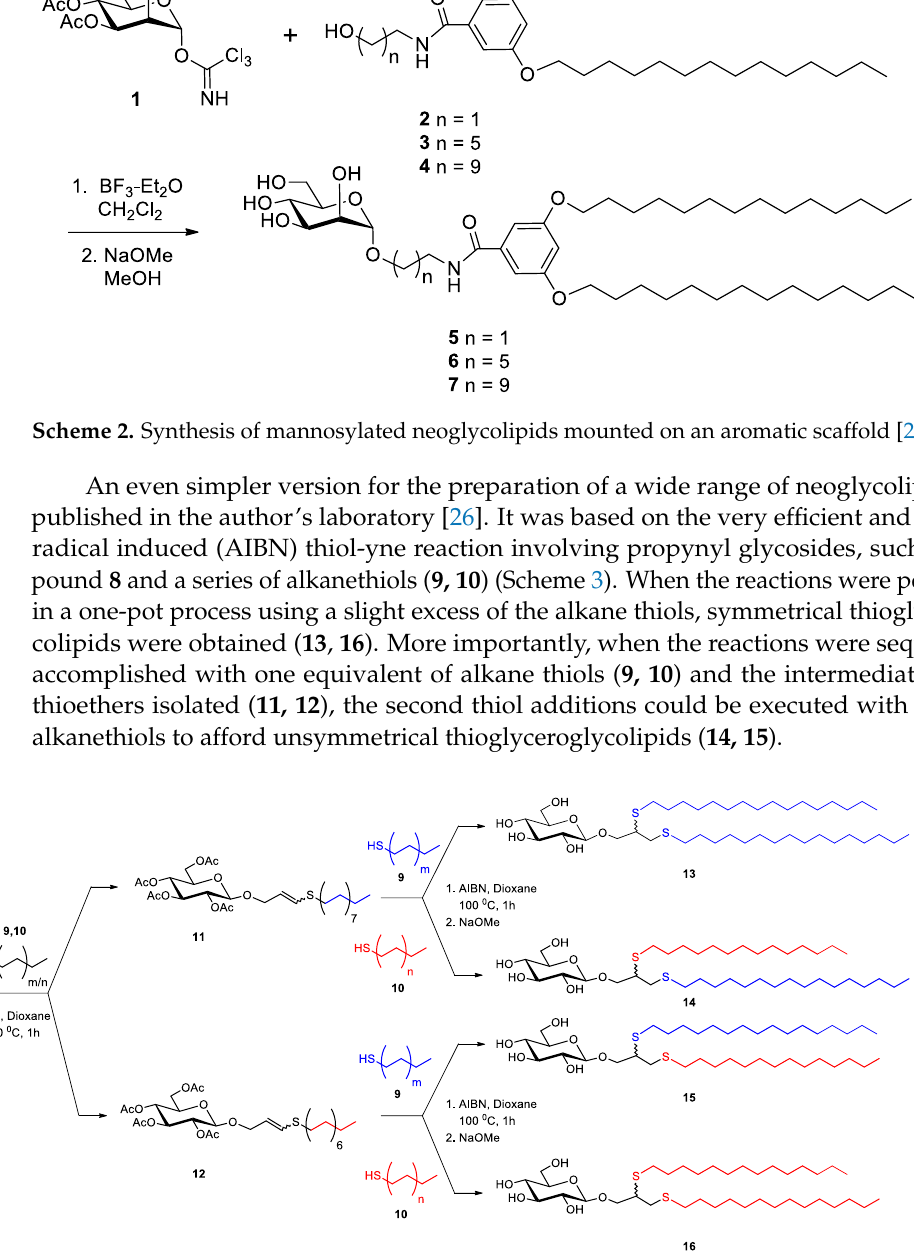
Scheme 3. Neoglycolipids synthesized by sequential thiol-yne reactions afford lipids that may contain two different hydrophobic tails [26].